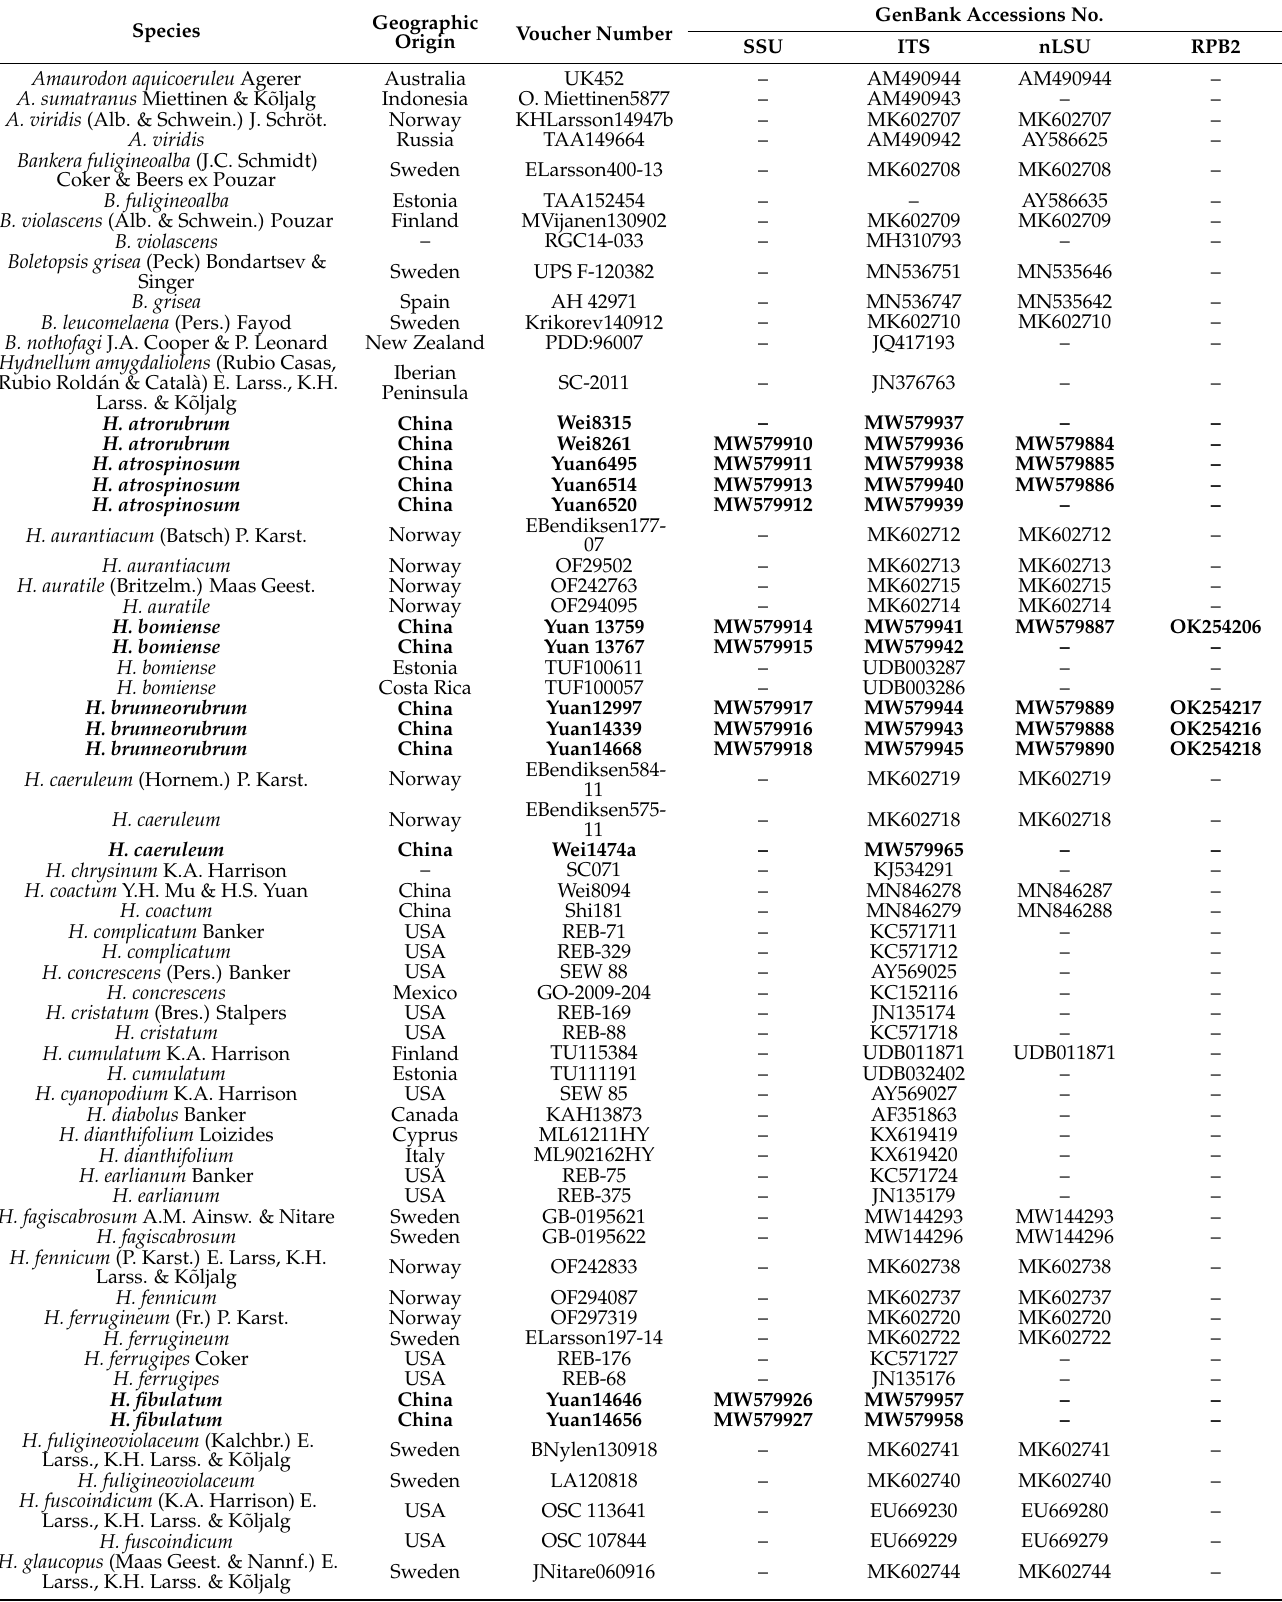
Table 1. Voucher numbers, geographic origins and GenBank accession numbers for the specimens included; sequences produced in this study are in